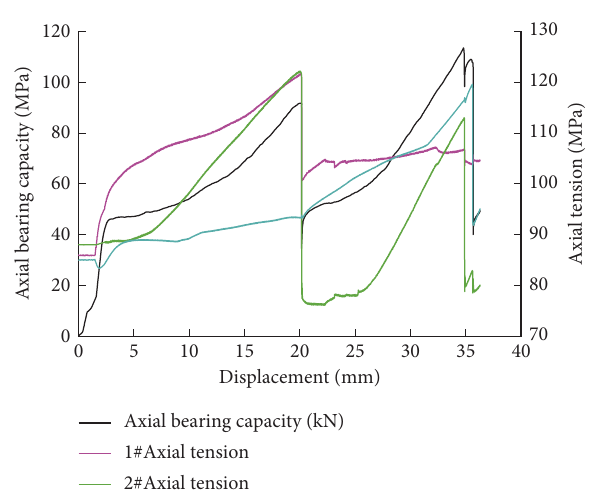
Figure 4: Te change in the curve of internal force of bolt in direct